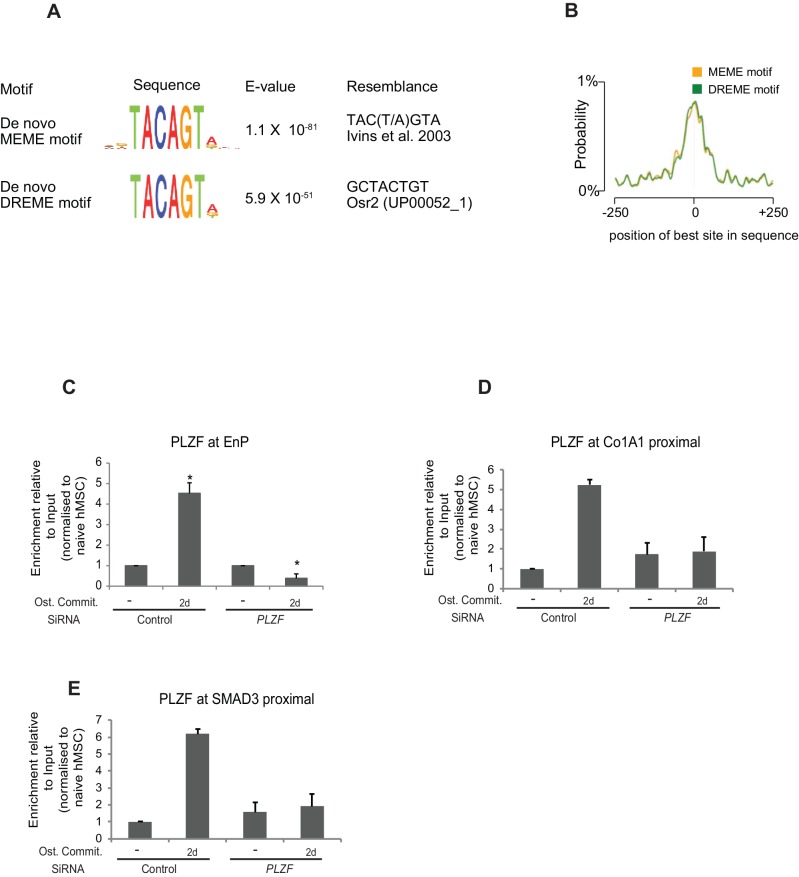
(A) Top motifs and output from discriminative de novo motif analysis of d10 PLZF peaks and random negative control regions matched to the peaks in terms of TSS distance and orientation.The most significantly enriched motif from two different algorithms are shown. (B) Profile of the average motif enrichment across PLZF peaks. Both output from MEME and DREME are centrally enriched at the PLZF peaks. (C) Validation of specificity of the PLZF antibody in ChIP was performed by siRNA mediated PLZF knockdown followed by osteogenic induction for 2 days. (C) The ChIP-QPCR data is shown in the plot at the EnP element. Data shows mean ± SD from triplicates of QPCR from three biological replicates (p < 0.05, two tailed t-test). DPLZF bound genomic region proximal to Col1A1 gene. Data shows mean ± SD from triplicates of QPCR. (E) PLZF bound genomic region proximal to SMAD3 gene. Data shows mean ± SD from triplicates of QPCR.Figure 2—figure supplement 1—source data 1.Validation of PLZF antibody in ChIP by PLZF kncokdown.